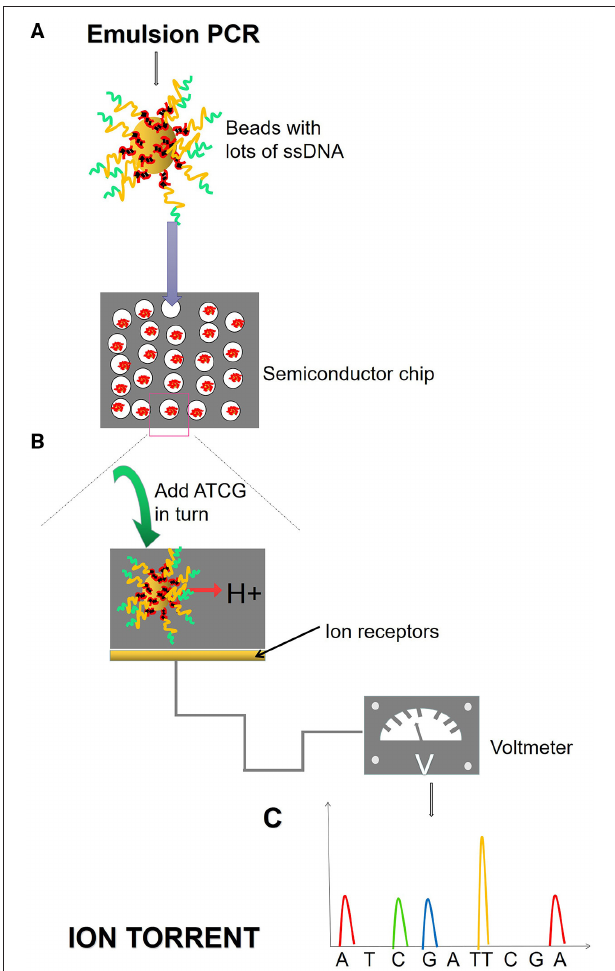
FIGURE 5 | Ion torrent process. (A) Emulsion PCR. After the emulsion is amplified, a large number of amplified products from the DNA template are attached to the magnetic beads. Magnetic beads are fixed in the micropores of the semiconductor chip, and each micropore can only contain one magnetic bead. (B) SBS. Fix the ssDNA in the micropore of the semiconductor chip and add different dNTPs in turn. When the DNA polymerase polymerizes the nucleotide onto the DNA strand in the extension, it will release an H + , causing the change of pH value and voltage in the reaction system. (C) The electrical signal is accepted and converted into base information.